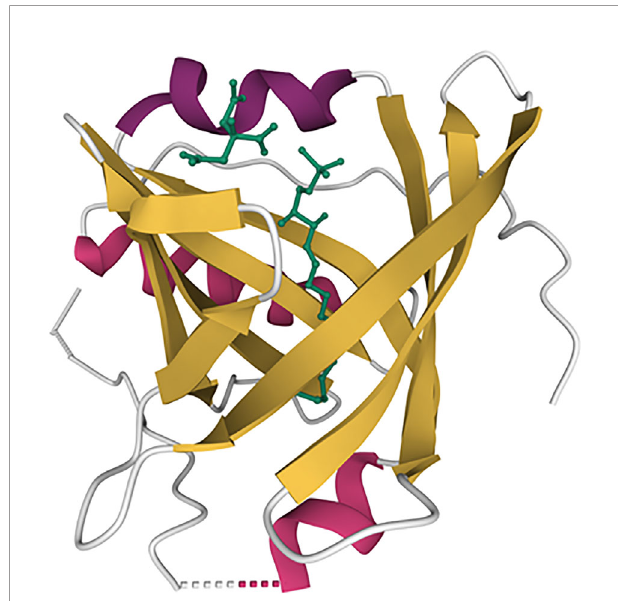
FIGURE 1 | Illustration of the apoM structure with S1P. Beta-sheets are represented by yellow lines and alpha helix are represented by purple colors. The S1P molecule is represented by the green line. The model is based on the RCSB protein data bank ID 2YG2